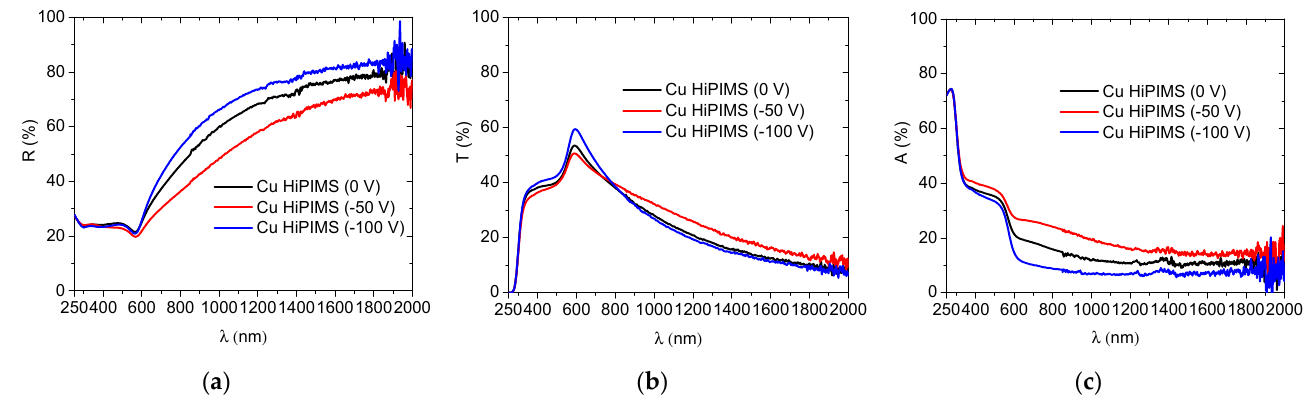
Figure 3. Comparison between reflectivity ( a ), transmission ( b ), and absorption ( c ) spectra of copper thin films obtained by using HiPIMS techniques at different substrate bias voltages.